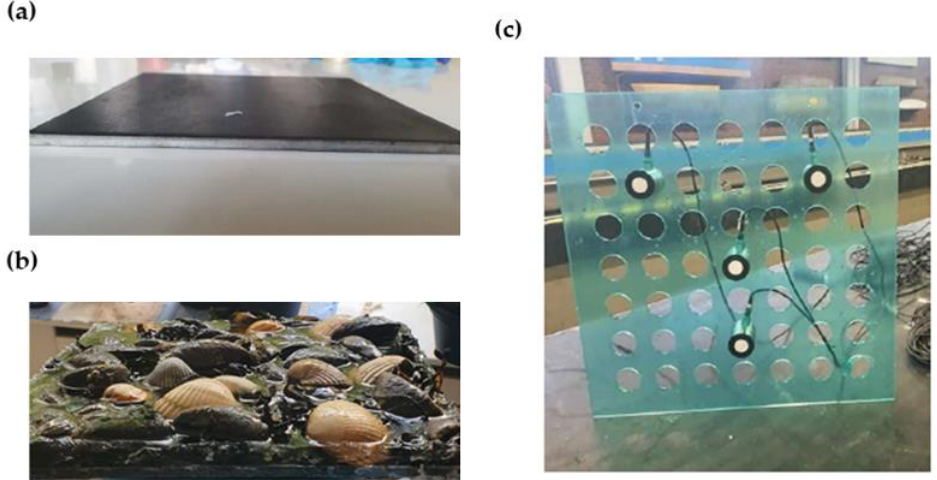
Figure 3. Test specimen ( a ) baseline plate and ( b ) marine growth covered plate. ( c ) Sensor holder with four ultrasound transducers.